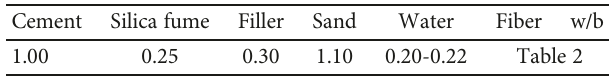
Table 1: The proportion of materials in the NSHSC mixture by cement weight